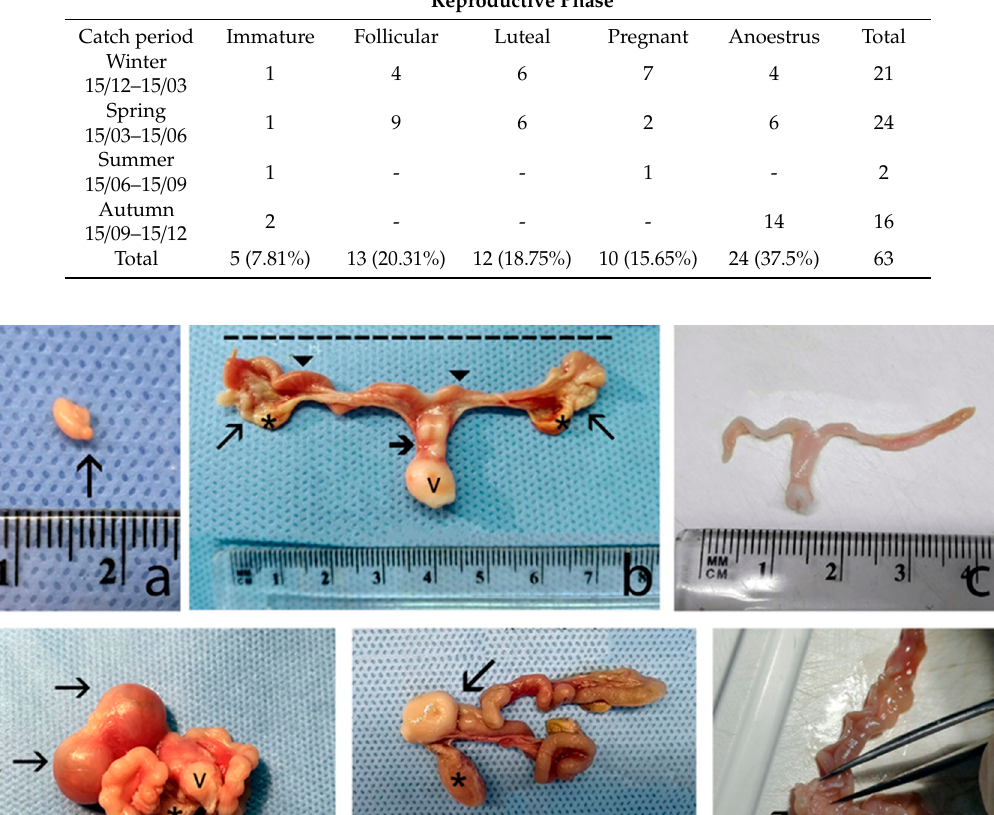
2 of 15 Table 2. Seasonal distribution of female squirrels according to their reproductive phases.